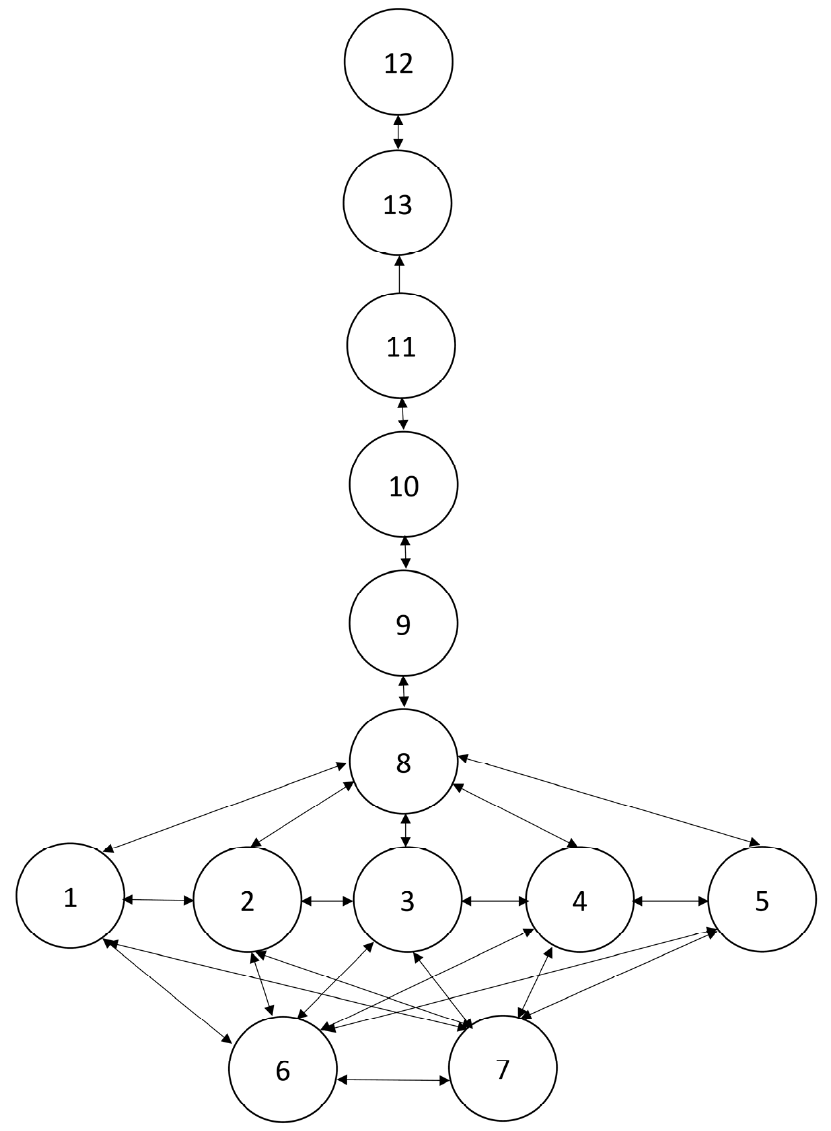
Figure 1. Learning trajectory of counting and arithmetic concepts for boys. Notes: 1 = oral counting from 1 to 30; 2 = one-to-one correspondence counting within 30; 3 = cardinality within 30; 4 = numerical literacy within 30; 5 = sum (under 10) of two numbers; 6 = difference (under 10) between two numbers; 7 = compose and decompose number 10; 8 = forward verbal counting 30 num- bers from a specific number within 30; 9 = backward verbal counting from a specific number within 30 to 1; 10 = unknown addend (within 30); 11 = unknown subtrahend (within 30); 12 = unknown summand (within 30); 13 = unknown minuend (within